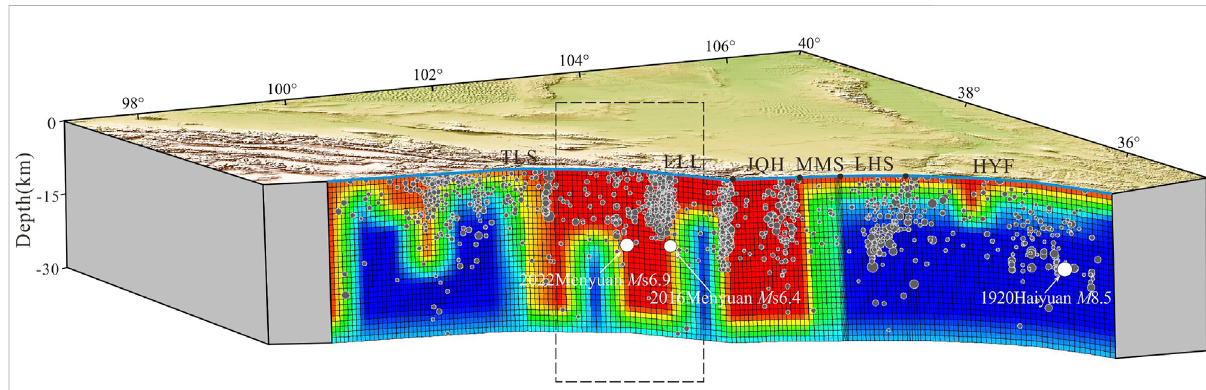
FIGURE 7 Locking degree and distribution of small earthquakes in the Qilian – Haiyuan fault zone. The white circles indicate the locations of the 1920 Haiyuan M 8.5, 2016 Menyuan M S 6.4, and 2022 Menyuan M S 6.4 earthquakes. The gray circles are the relocation catalog of small earthquakes during2009 – 2019.Blackdottedrectangleshowsthepro fi leofsmallearthquakesinFigure9.TLSF:Tuolaishanfault;LLLF:Lenglonglingfault;JQHF: Jinqianghe fault; MMSF: Maomaoshan fault; LHSF: Laohushan fault; HYF: Haiyuan